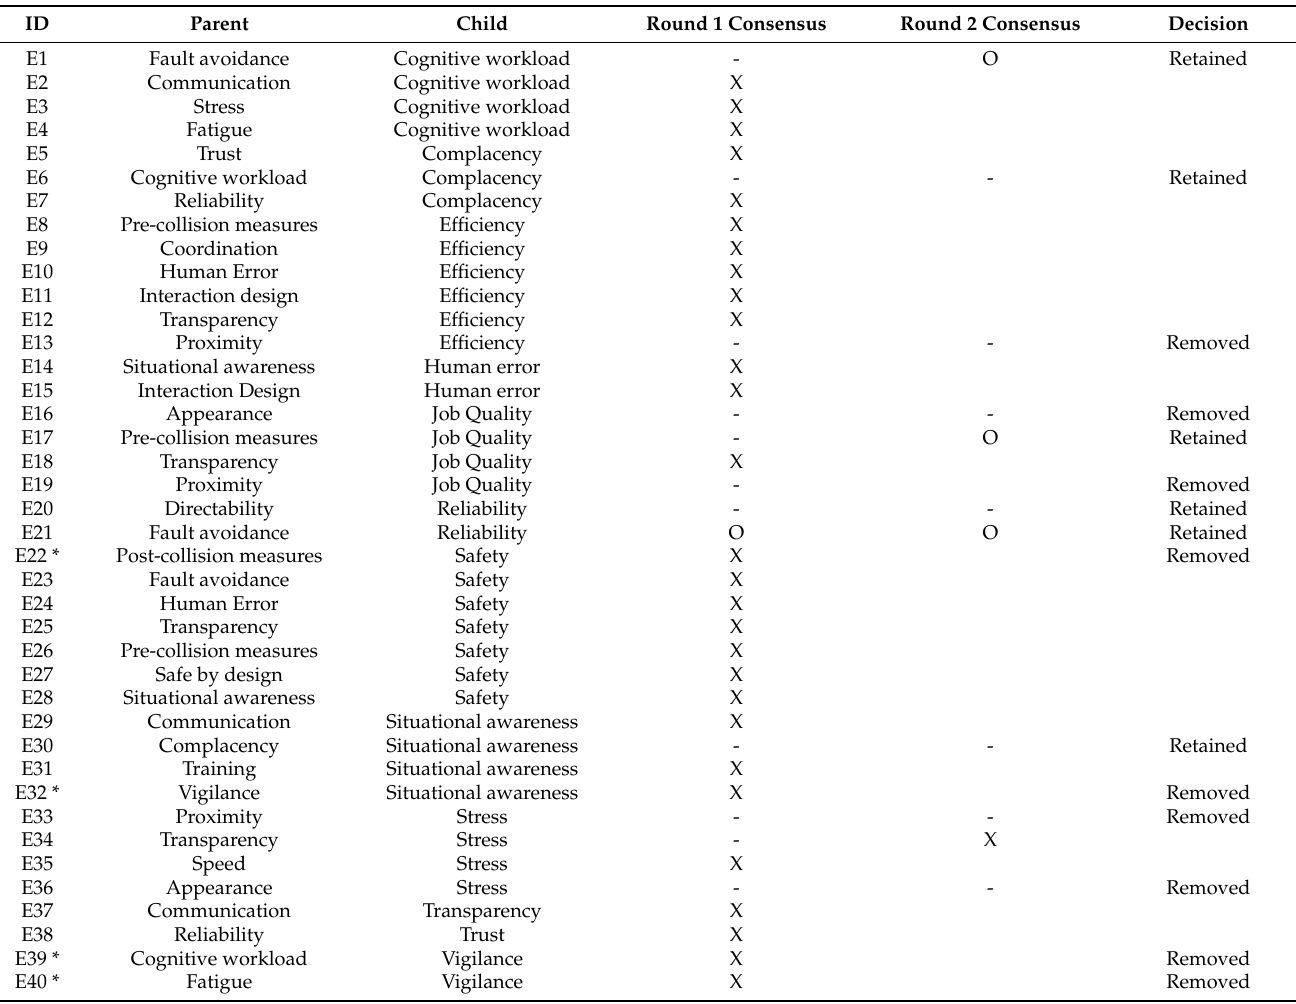
Table 1. Consensus results and decisions for relationships in the